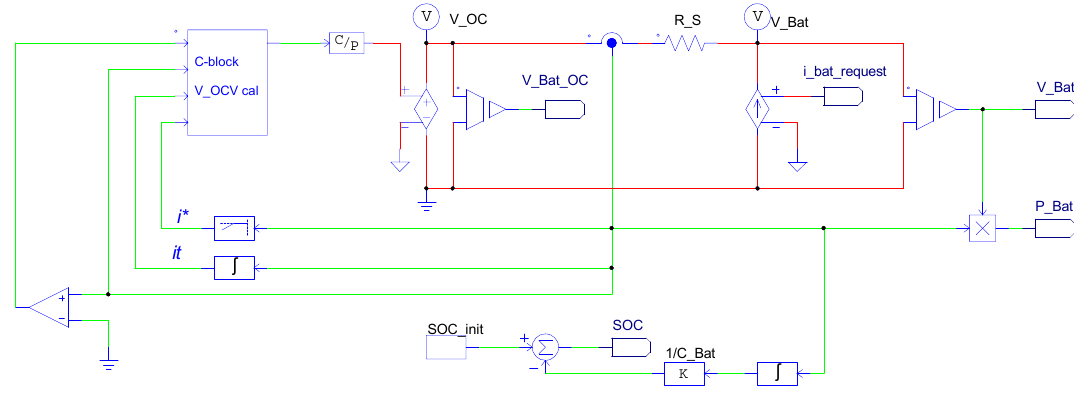
Figure 14. Implementation of the Sherpherd’s model.